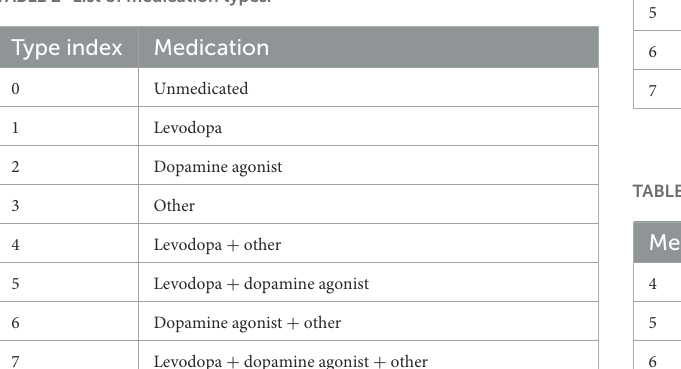
TABLE 2 List of medication types.